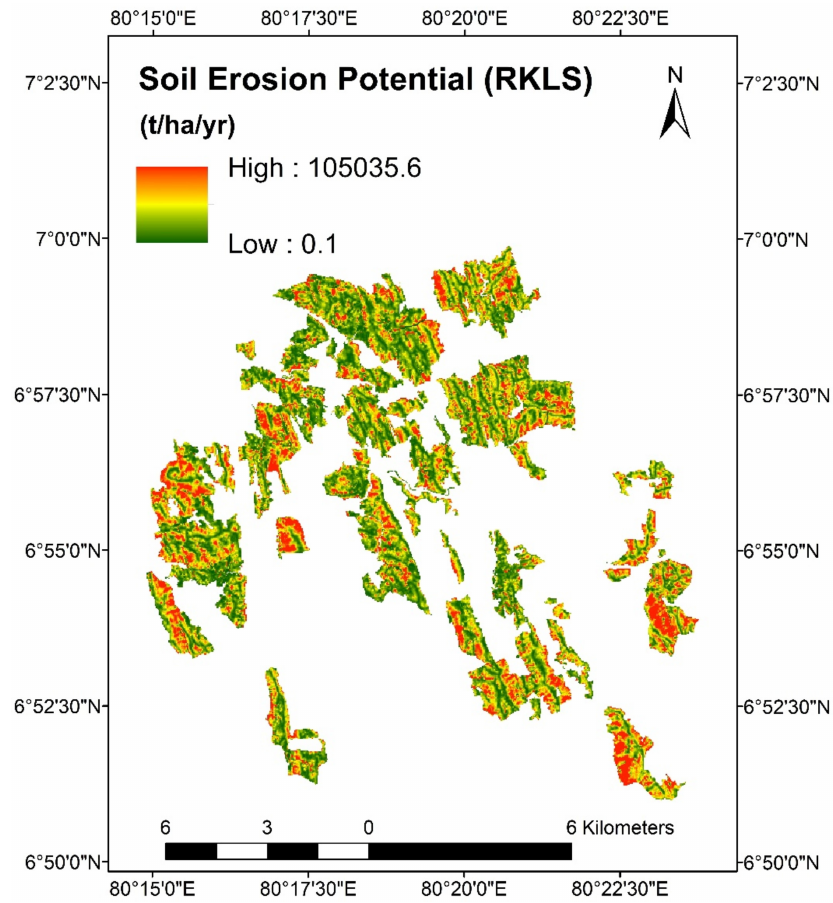
Figure 6. Soil erosion potential map (RKLS) of the study